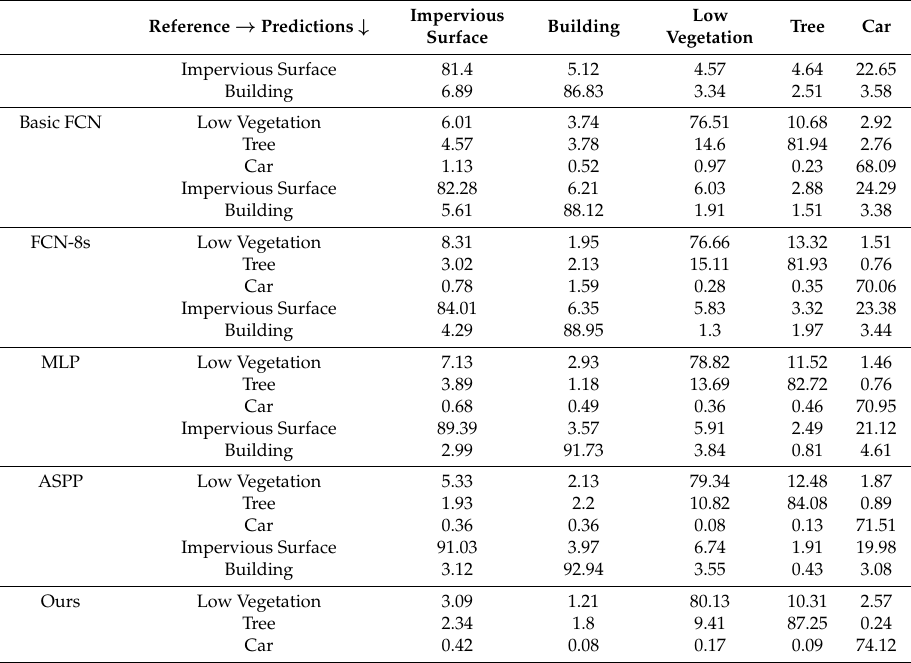
Table 3. Confusion matrix for the Vaihingen